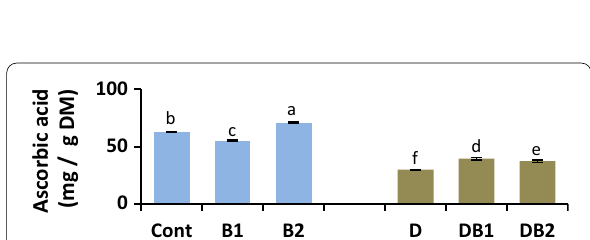
Fig. 5 Effect of bacterial inoculation with Azospirillum brasilense NO40 (B 1 ) and Stenotrophomonas maltophilia B11 (B 2 ) on the content of ascorbic acid in the leaves of 15-day-old Triticum aestivum L. seedlings (cv. G9) grown in sandy soil, under unstressed and drought stressed conditions (7 days of water withholding). Error bars represent the standard deviation between 3 replica. Treatments with identical letters are not significant at P 0.01. Cont. unstressed-uninoculated ≤ ≡ treatment; D drought-stressed-uninoculated treatment; ≡ unstressed-inoculated treatments; DB 1 and B 1 and B 2 ≡ DB 2 drought-stressed- inoculated treatments =